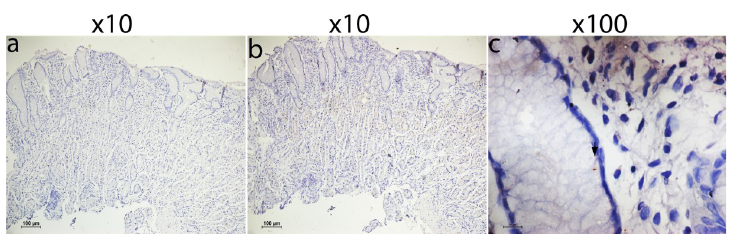
Fig 7. Identification of M . abscessus in gastric biopsy sections using Immunohistochemistry. (a) Immunohistochemistry of gastric biopsy section secondary antibody control without the primary antibody (b) Immunohistochemistry of gastric biopsy section with the ab905 antibody treated gastric biopsy section at 10X magnification. (c) Immunohistochemistry of gastric biopsy section using the ab905 antibody shows the presence of M . abscessus in the gastric tissue section at 100X